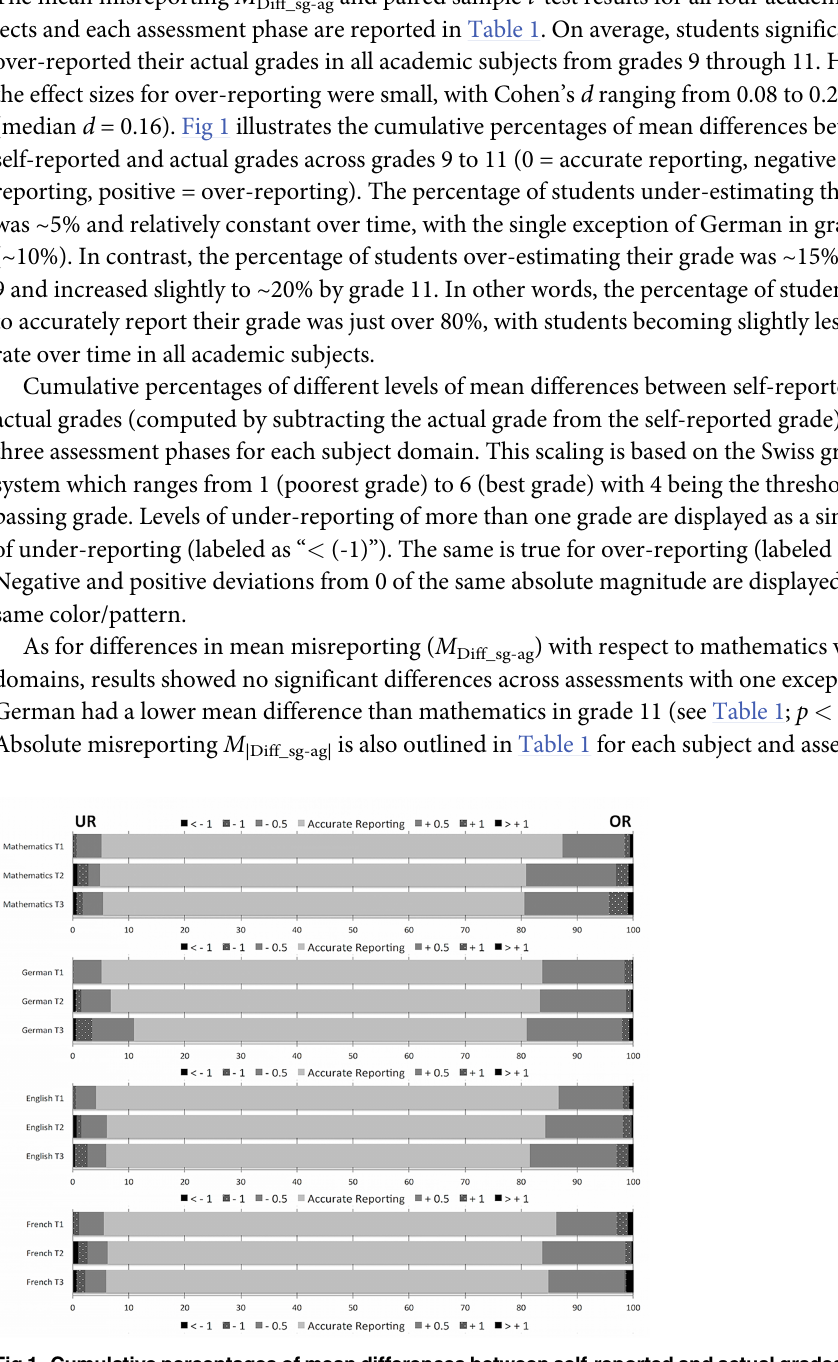
PLOS ONE | https://doi.org/10.1371/journal.pone.0187367 November7,